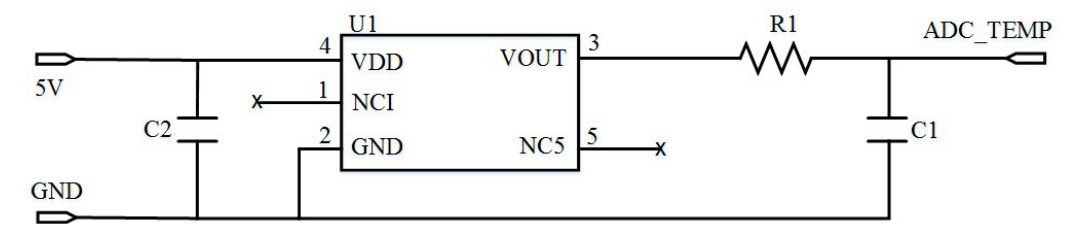
Figure 15. A typical temperature monitoring IC of